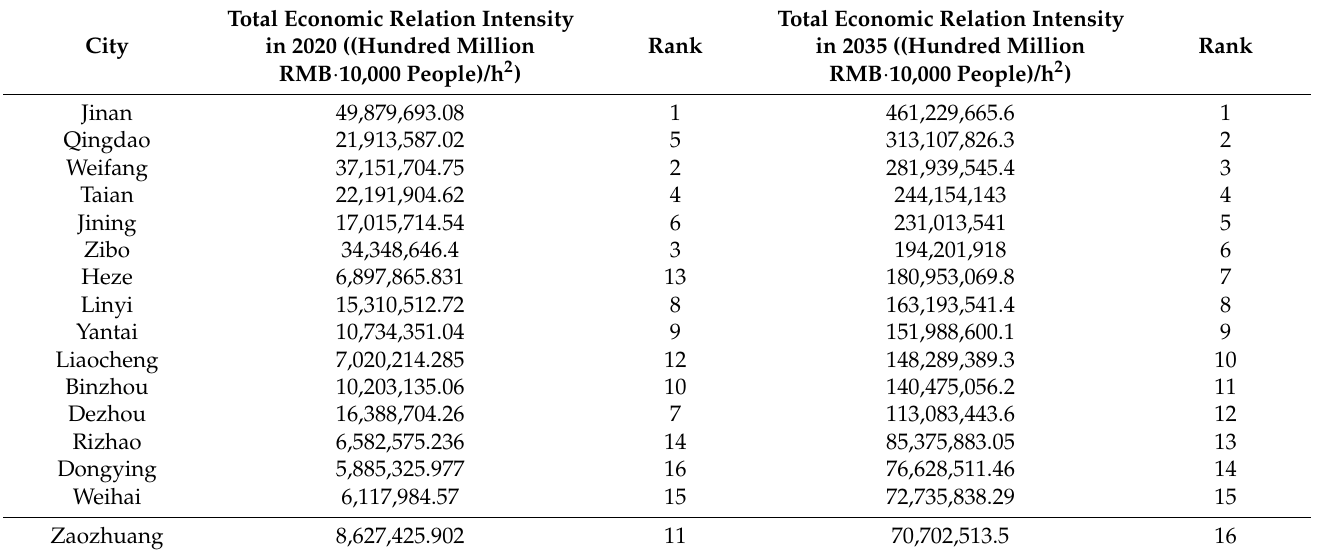
Table 2. Total urban economic relation intensity in Shandong Province, China, in 2020 and 2035.